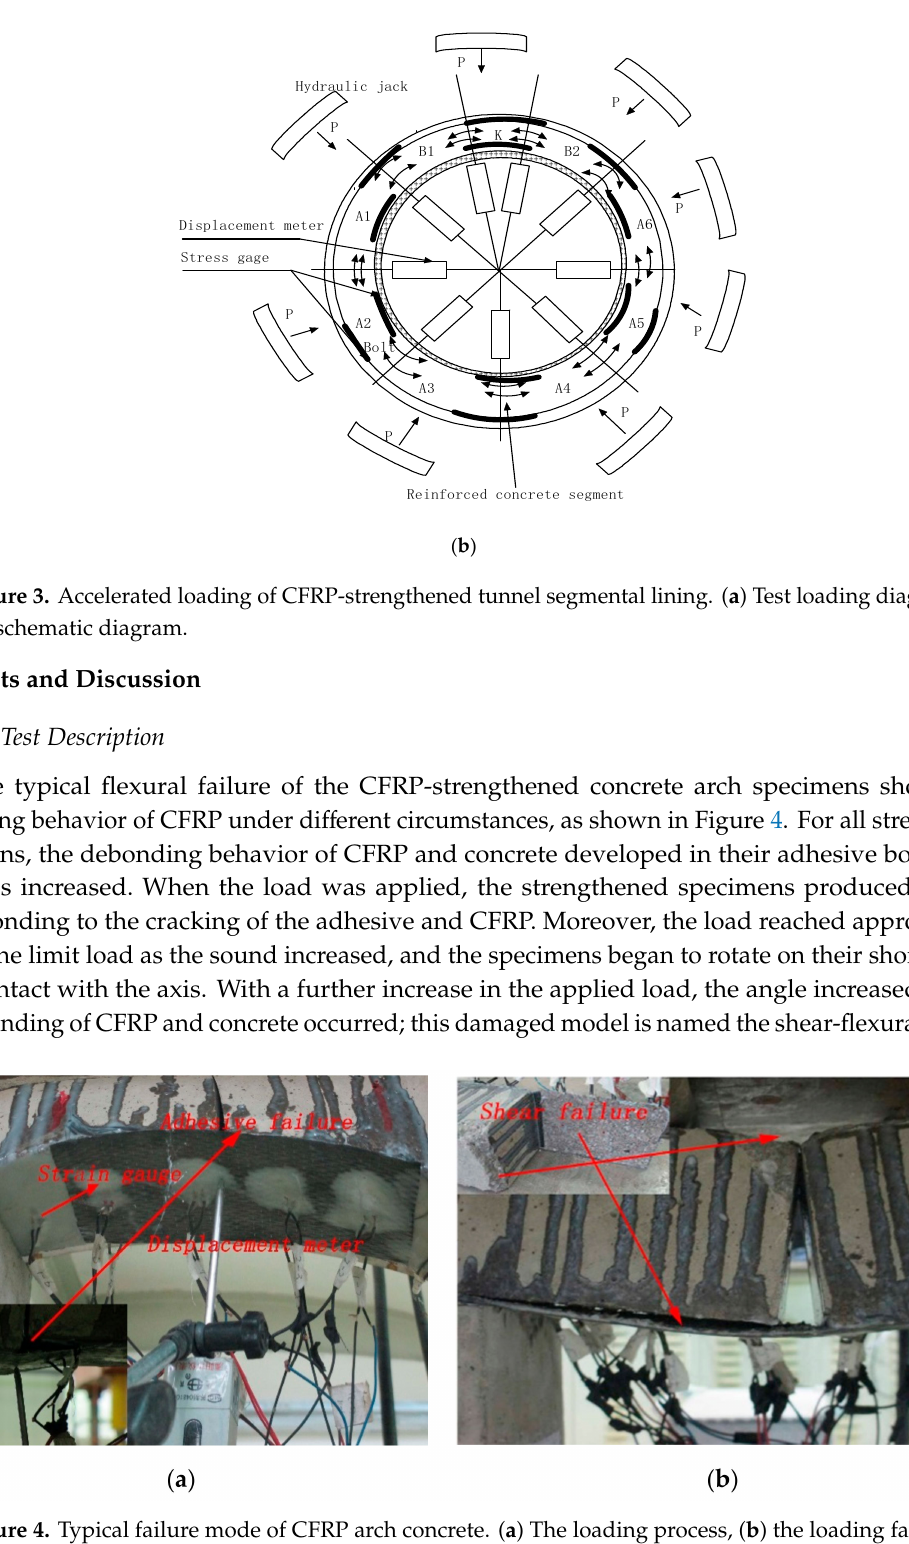
Figure 4. Typical failure mode of CFRP arch concrete. ( a ) The loading process, ( b ) the loading